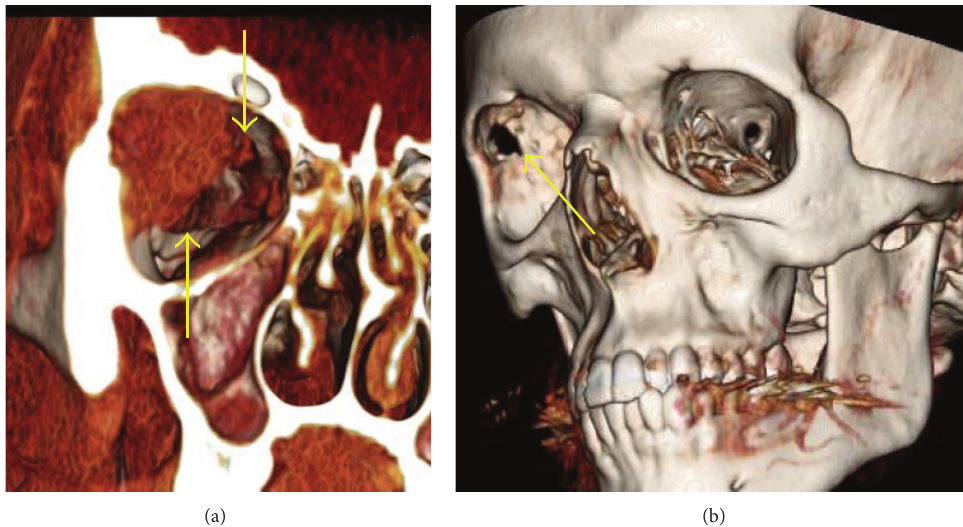
Figure 3: Involvement of adjacent bony structures by tumor demonstrated by 3D imaging. A 17-year-old man with poorly differentiated lacrimal gland adenocarcinoma “salivary duct carcinoma ex-pleomorphic adenoma.” (a) 3D image, soft tissue window: soft tissue tumor and relation to the extraocular muscles (arrows). (b) 3D image, bone window (soft tissue subtracted). The tumor has been removed to reveal the underlying bone destruction (arrow).